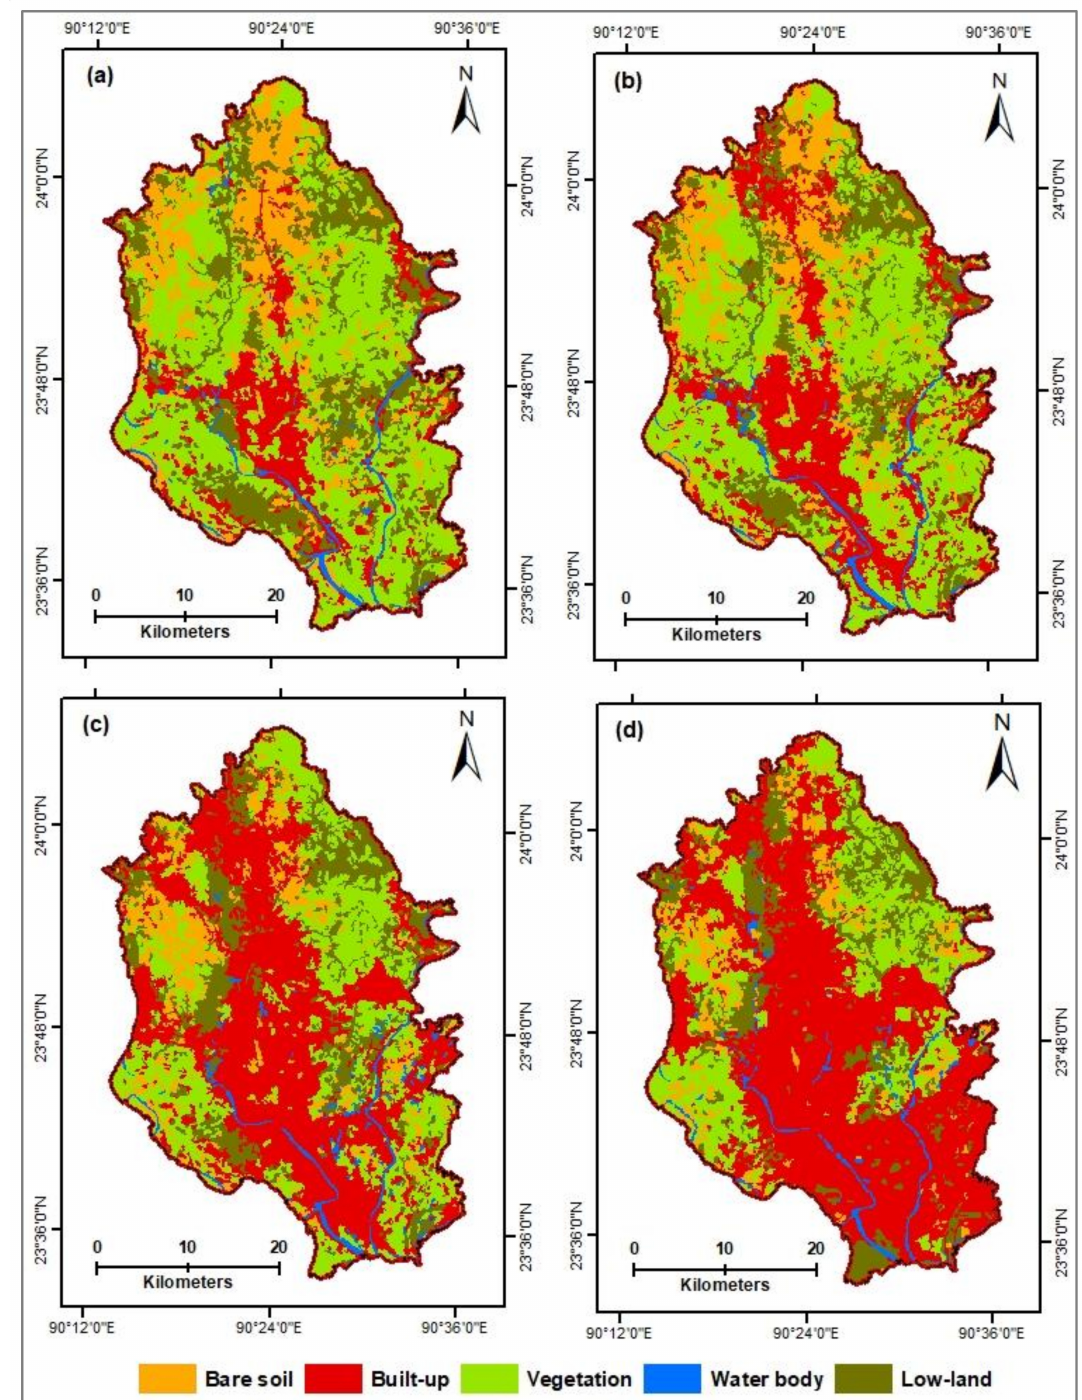
Figure 6. ( a ) Classified DMDP image from 1989; ( b ) classified DMDP image from 1999; ( c ) classified DMDP image from 2009; ( d ) classified DMDP image from